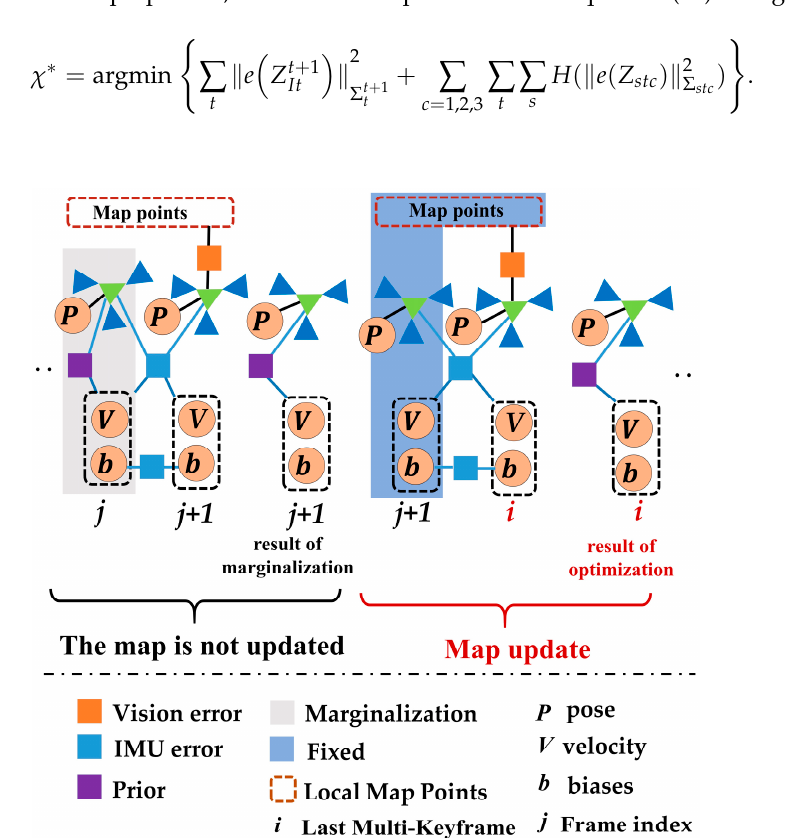
Figure 9. Motion-only BA optimization for tracking local map in our VINS-MKF.